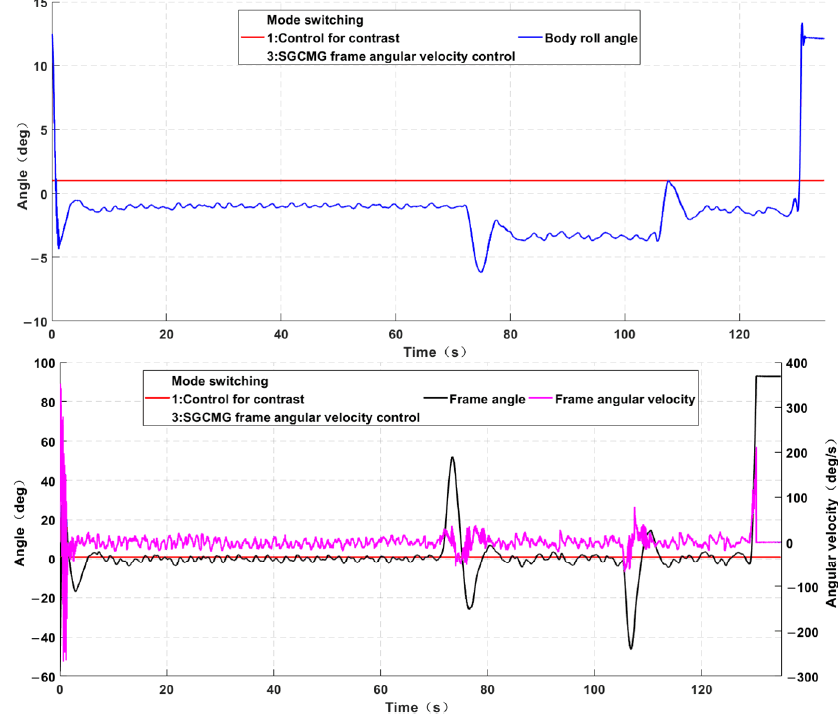
Figure 24. Experimental results: Comparison of controller load tests.